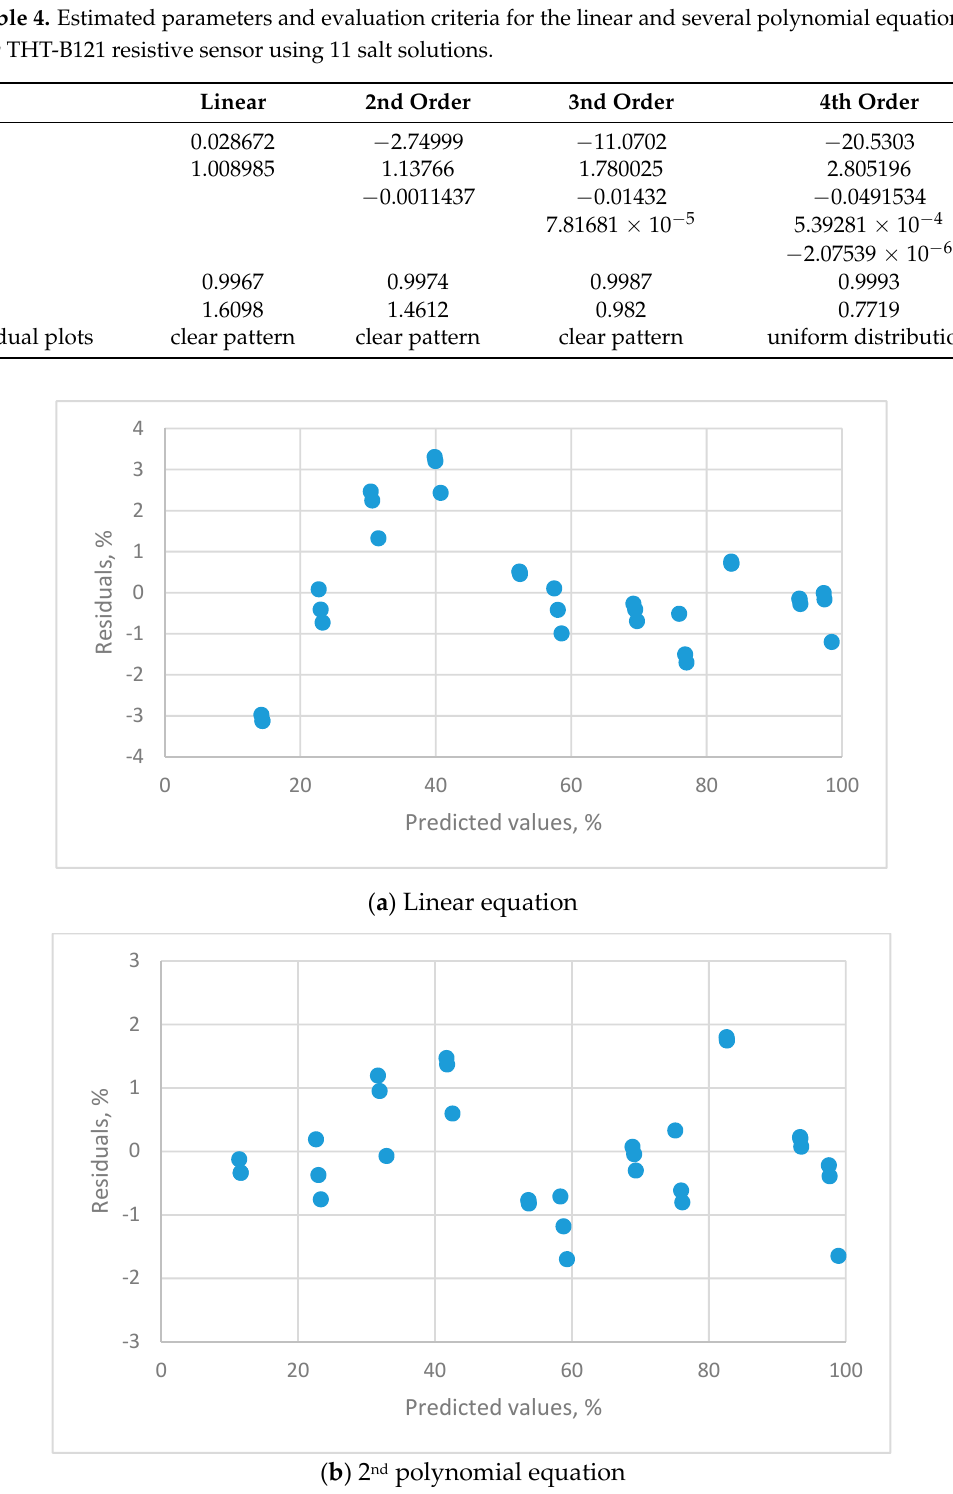
Figure 2. The distribution of the relative humidity data for reading values versus the standard humidity values for THT-B121 resistive humidity sensor using 11 saturated salt solutions (LiCl, CH 3 COOK, MgCl 2 , K 2 CO 3 , Mg(NO 3 ) 2 , NaBr, KI, NaCl, KCl, KNO 3 and K 2 SO 4 ).